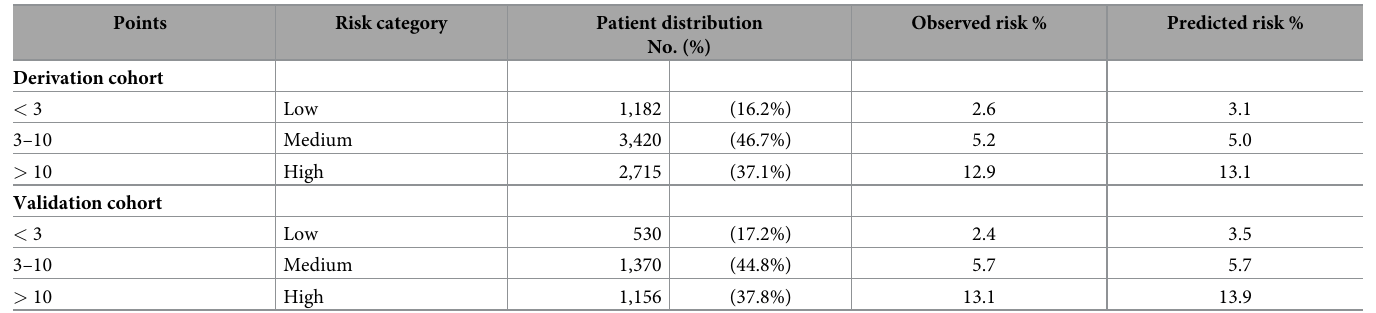
Table 4. Observed versus predicted risk of 30-day potentially avoidable